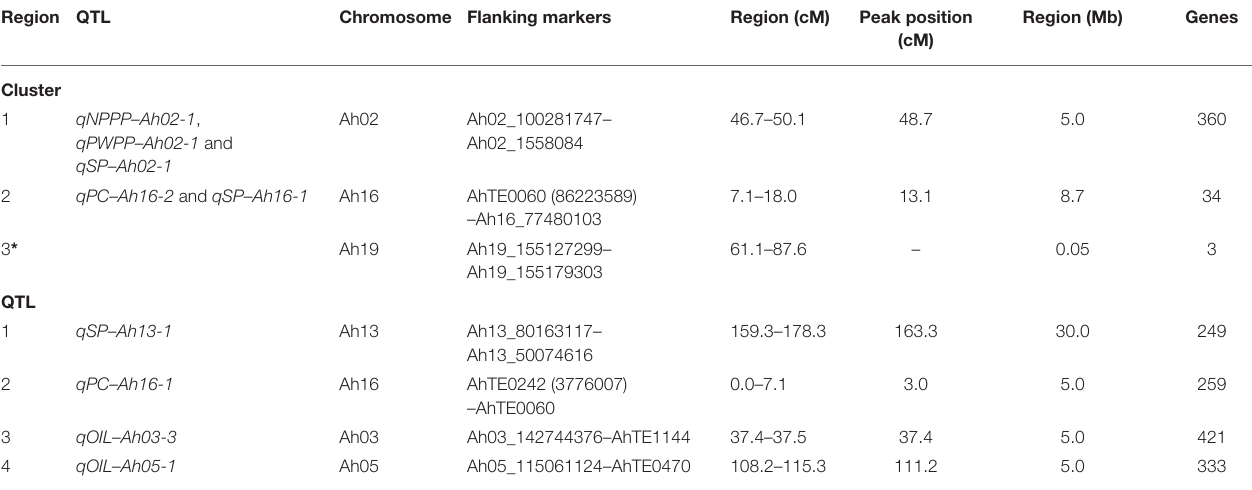
TABLE 4 | Putative genes identified in the major main effect QTL cluster/QTL regions for productivity and quality traits in the RIL population of TMV 2 and TMV 2-NLM of peanut. Region QTL